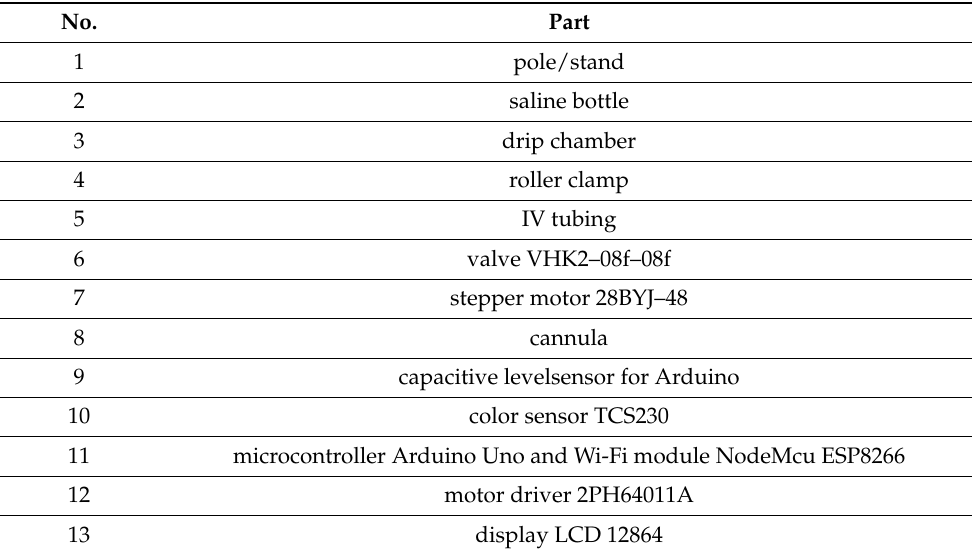
Table 4. IV infusion dosing system